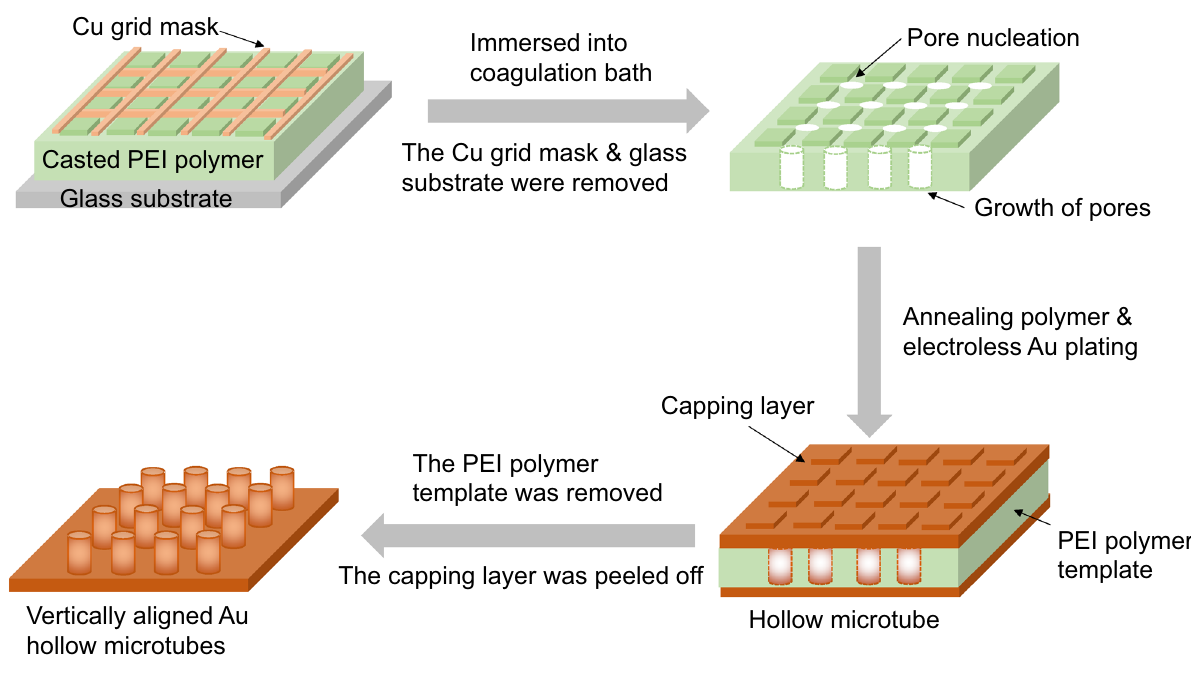
Figure 1. Vertically aligned gold microtube fabrication process.